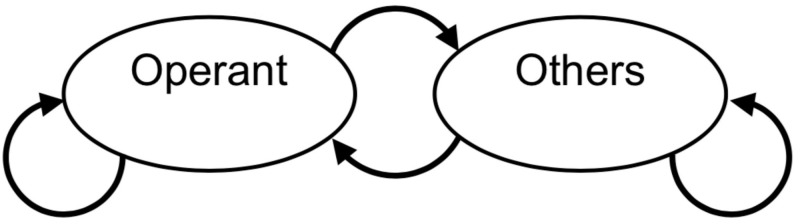
Two-state model.